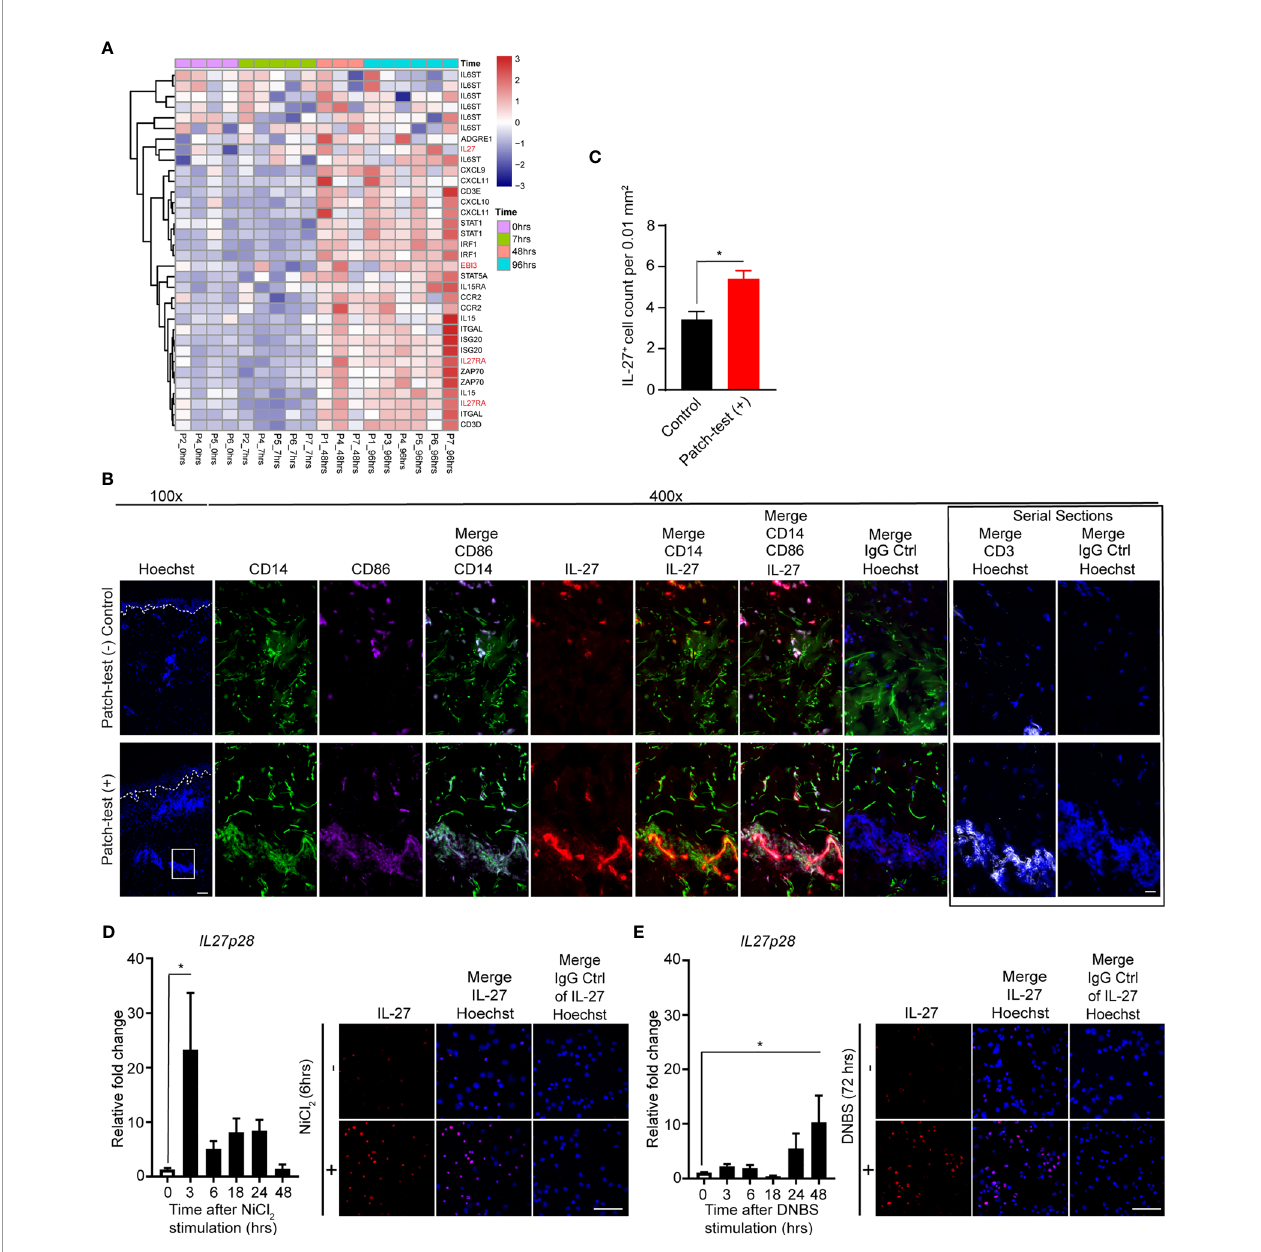
FIGURE 2 | Myeloid cells produce IL-27 upon allergen exposure. (A) Heat map showing gene expression patterns of patch-tested skin from allergic contact dermatitis patients (GSE number: 6281). Samples for gene expression analysis were collected from positive patch-test reactions to nickel at 7, 48, and 96 hours post-elicitation as well as the 0h control. Samples and genes are clustered using correlation distance with complete linkage. (B) Representative immuno fl uorescence staining of IL-27 (red), CD14 (green), CD86 (purple), CD3 (white) and Hoechst (blue) in human donor-matched patch-test negative control and patch-test (+) ACD skin. Data are representative of 3 patient samples per stained condition. Original magni fi cation x100 (left) and original magni fi cation x400 (right) with scale bars 100 µm, and 20 µm, respectively. White dashed lines mark the epidermal-dermal junction. (C) Analysis depicting total numbers of dermal IL-27 + cells in donor-matched patch-test negative control and patch-test (+) ACD samples. Data are expressed as mean ± SEM from at least three separate microscopic fi elds from 3 patients, *p < 0.05 (unpaired Student ’ s t test). (D, E) Quantitative PCR and representative immuno fl uorescence staining of IL-27 of THP-1 cells treated with (D) nickel chloride (NiCl2, 100µM) and (E) dinitrobenzene sulfonic acid (DNBS, 0.05%) at various time points. Data are summarized as mean ± SEM from at least 3 biological replicates, *p < 0.05 (ANOVA test with Bonferroni